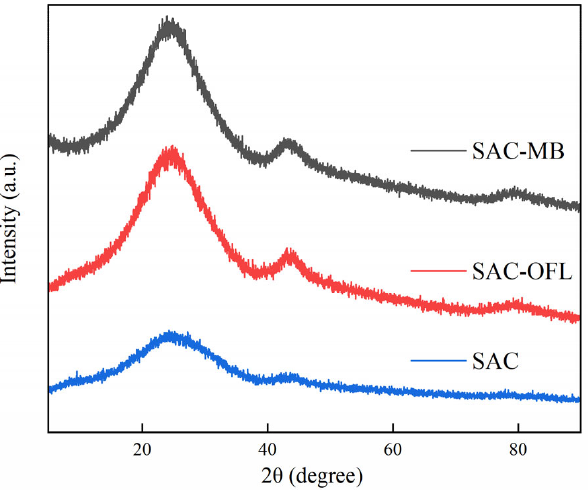
Figure 2. XRD plots of the initial state of the SAC and the adsorbed saturated MB and OFL. The functional groups on the SAC surface before and after the adsorption of MB and OFL were observed with an FT-IR spectrophotometer from ZEISS Merlin, Germany. The spectra obtained are shown in Figure 2.